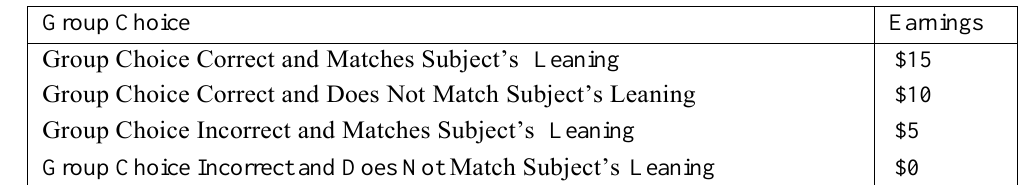
Table 1: Group Outcomes, Subject Leanings, and Subject Payments Decision